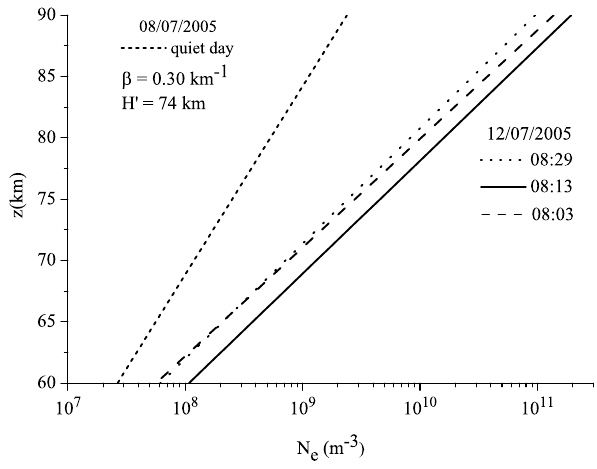
Fig. 10. Changes in the electron density profile in the course of flare C7.5. Pertaining phase and amplitude variation, as shown in Fig.